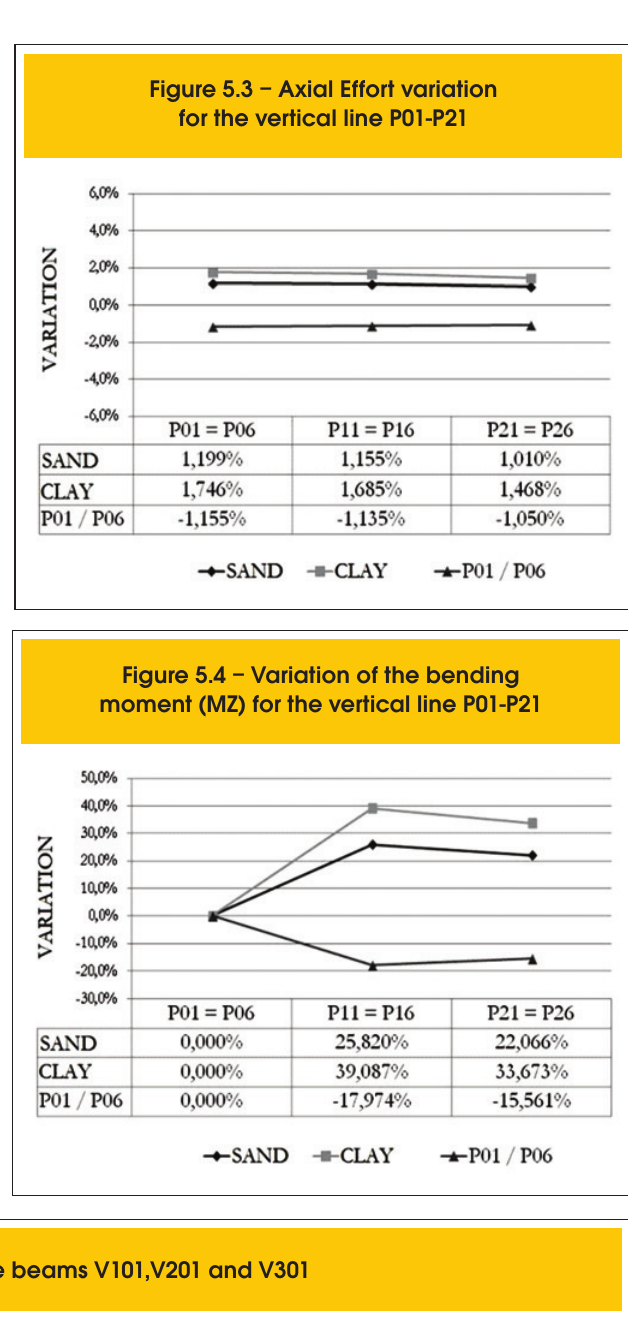
Figure 5.2 – Graphical analysis of the percentage change of the vertical reactions of the spatial structural model